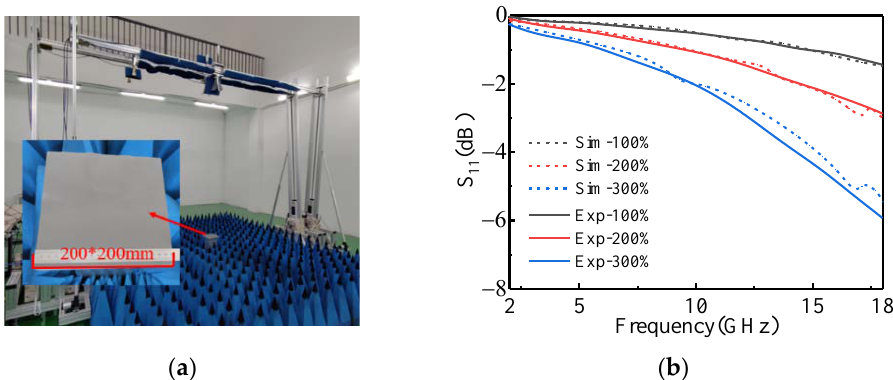
Figure 9. S-parameter analysis of the magnetic substrate; ( a ) is the test scenario and ( b ) is the comparison between S-parameter test results and calculation results.